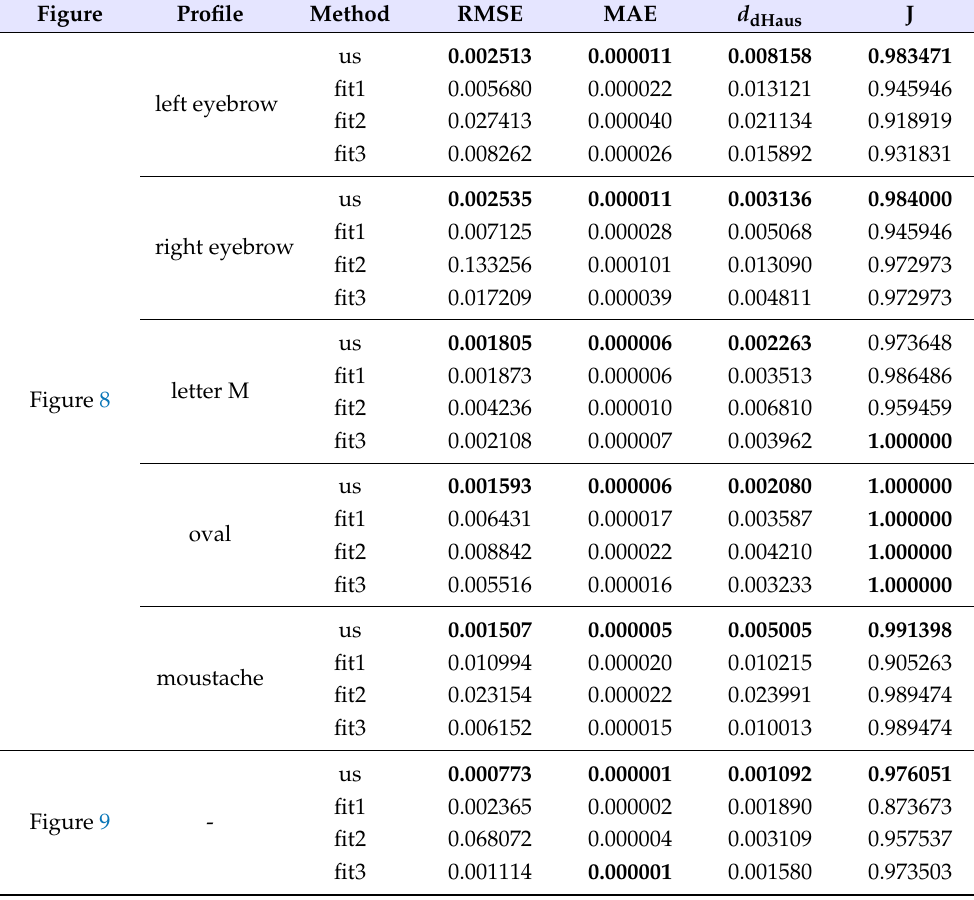
Table 2. Indicators for the examples in Figures 8 and 9. For each profile we report: the Root Mean Squared Error (RMSE), the Mean Absolute Error (MAE), the normalized directed Hausdorff distance d dHaus and the Jaccard index J . Here, fit1, fit2 and fit3 stand, respectively, for quadratic polynomial, piecewise cubic and smoothing spline fitting. For each figure and each indicator, the best performance is reported in